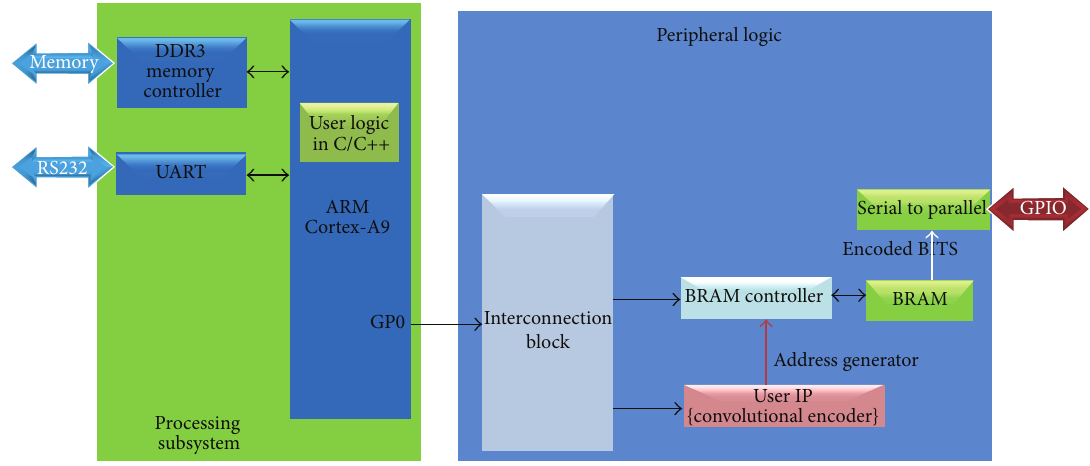
Figure 5: A system level implementation structure on FPGA along with ROM.